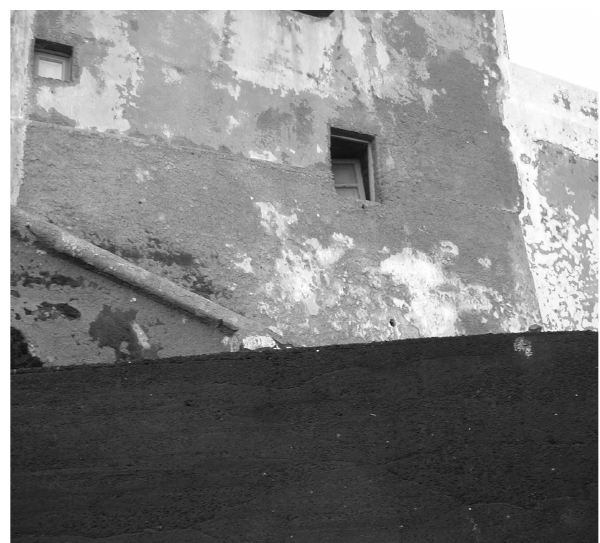
Fig. 8. View from north-west of building #1, at Piscit`a (Stromboli – Fig. 4). The picture was taken few days after the 2002 tsunami. The only visible damage is an unhinged window on first floor. The PTVA-3 Model classified building #1 as having a “very low” RVI score which correlates well with the actual damage sustained by this